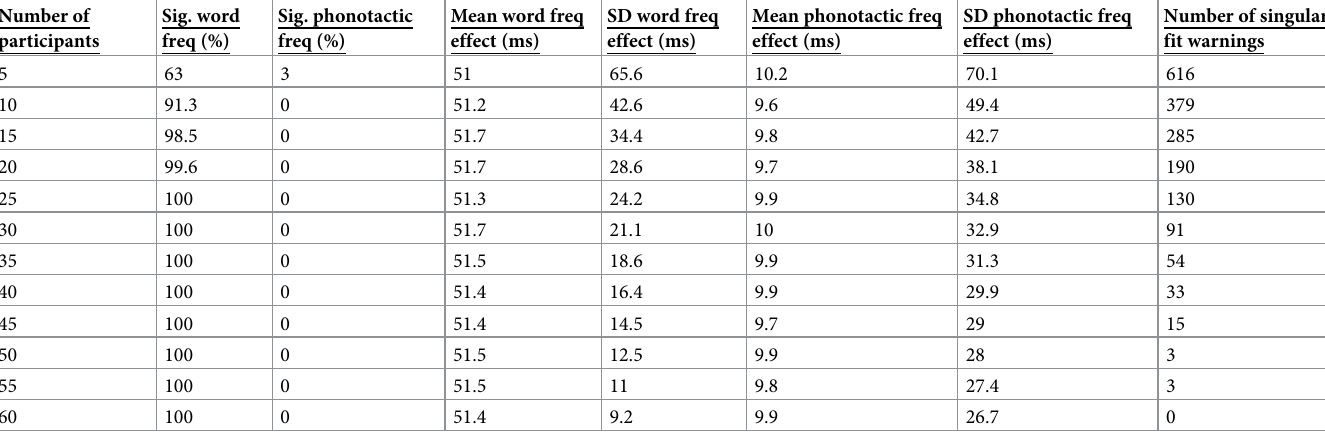
Table 5. Permutation approach to determine a sample size of participants necessary to detect a frequency effect. Number of